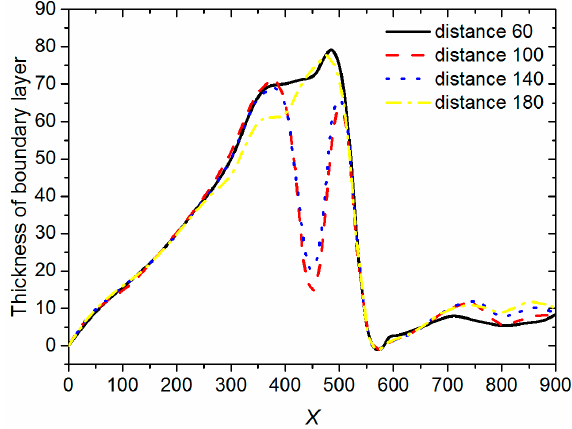
Figure 11. Thickness of the boundary layer of double cylinders at different n .